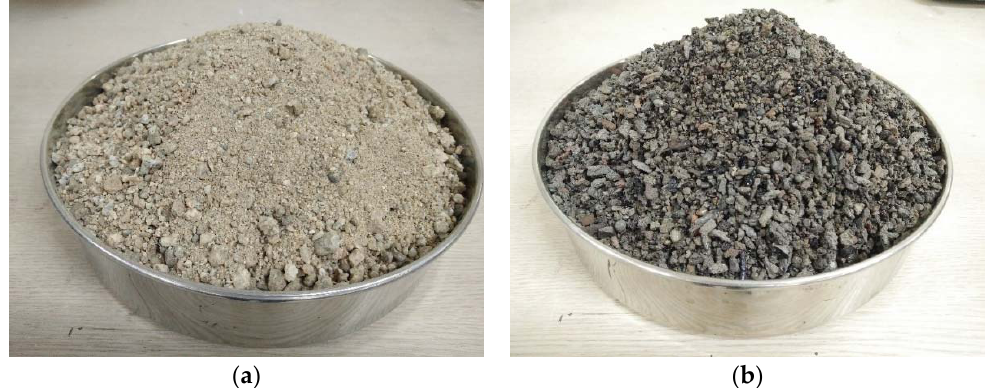
Figure 1. Crushed fine and CBA aggregates. ( a ) Crushed fine aggregate; ( b ) CBA aggregate. Materials 2019 , 12 , x FOR PEER REVIEW